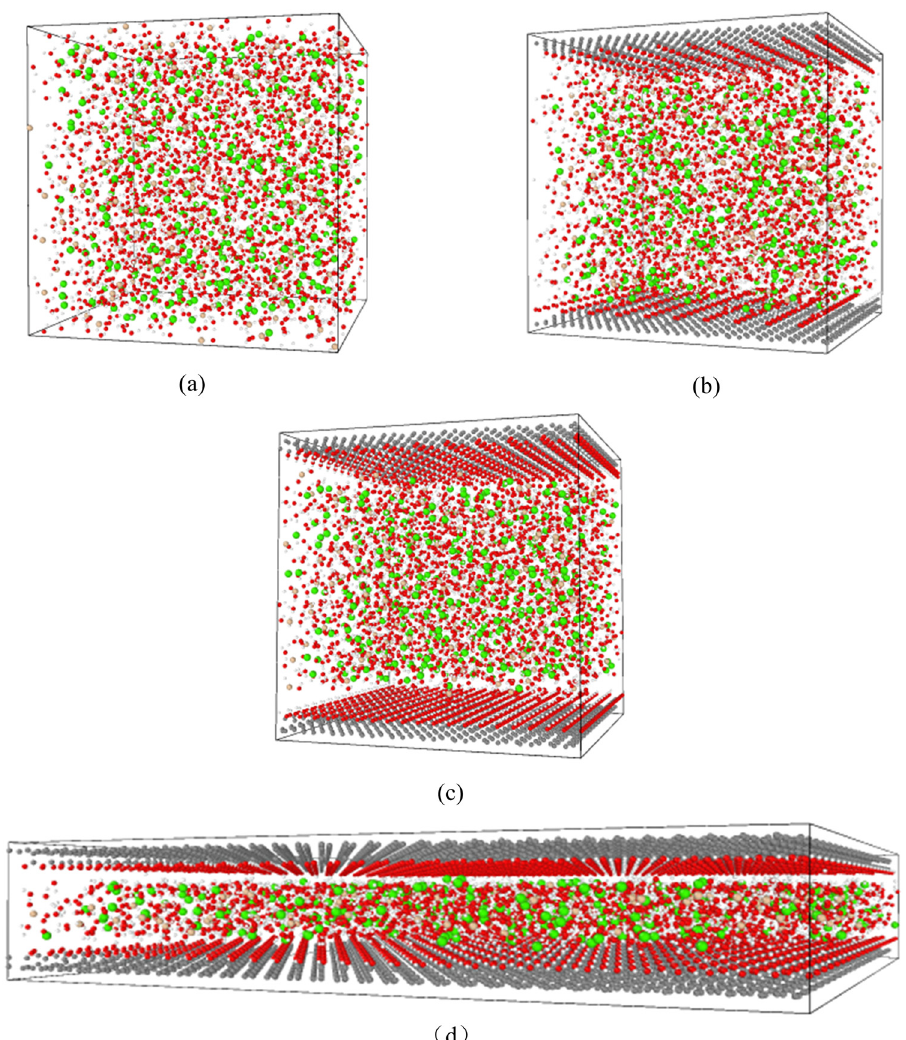
Figure 1: Initial system model ( C, O, H, Ca, and Si elements are shown in gray, red, white, green, and yellow, respectively ) . ( a ) Control, ( b ) GCOOH40 - 25, ( c ) GCOOH40 - 50, and ( d ) GCOOH10 -